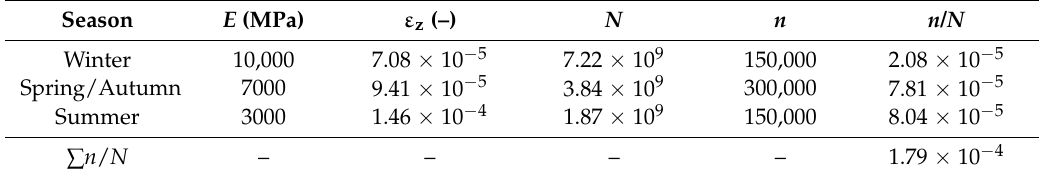
Table 5. Fatigue verification of asphalt layers.